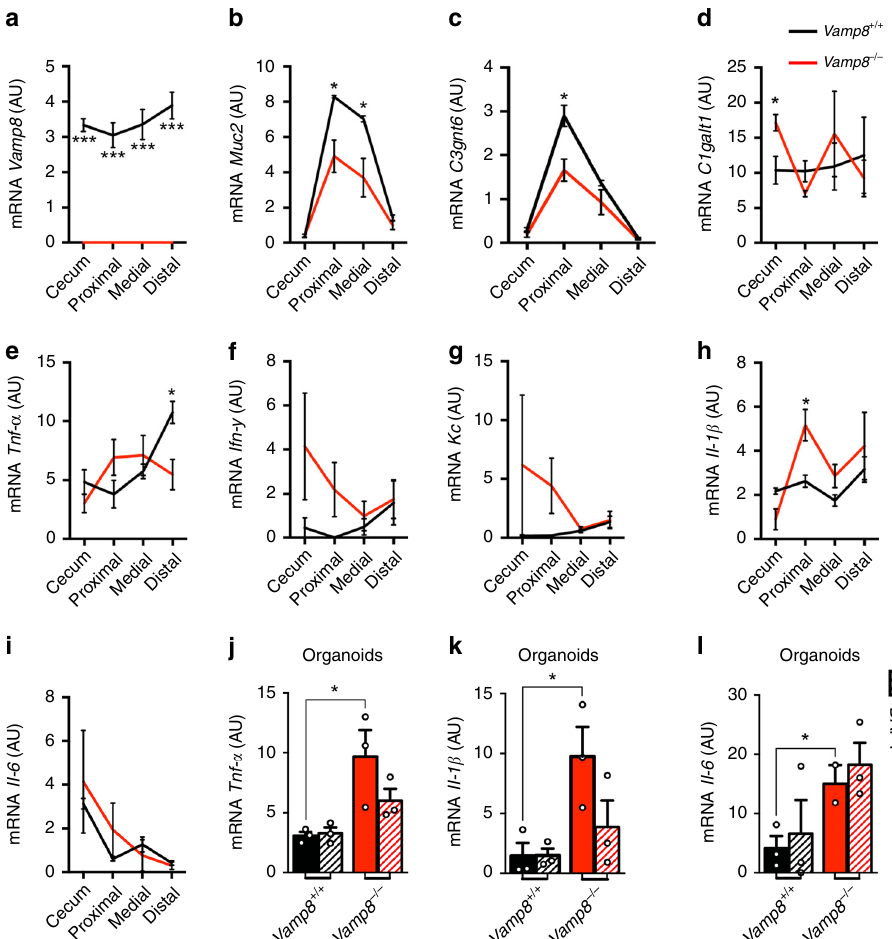
Fig. 3 Vamp8 − / − exhibits a mild pro-in fl ammatory phenotype due to improper mucin secretion. a In vivo , Vamp8 mRNA expression assessed in Vamp8 + / + and Vamp8 − / − littermates by qPCR on cecum, proximal, medial, and distal colon segments (representative data of one experiment independently repeated three times, >3 mice per group.) Goblet cell genes Muc2 b C3gnt6 c and C1galt1 d were analyzed by qPCR. The pro-in fl ammatory genes Tnf- α e , Ifn- γ f , Kc g , Il-1 β h , and Il-6 i were measured by qPCR. j – l Colonic organoids derived from Vamp8 + / + and Vamp8 − / − littermates were analyzed for mRNA expression of Tnf- α j , Il-1 β k , and Il-6 j with (hashed bars) and without skewing to a goblet cell lineage with 5 μ M DAPT for 24 h after 7 days in culture (representative data of one experiment independently repeated two times, three wells/condition). Bars indicate mean ± standard error of the mean. * P < 0.05, *** P < 0.001. Unpaired two-tailed Student's T -test a –